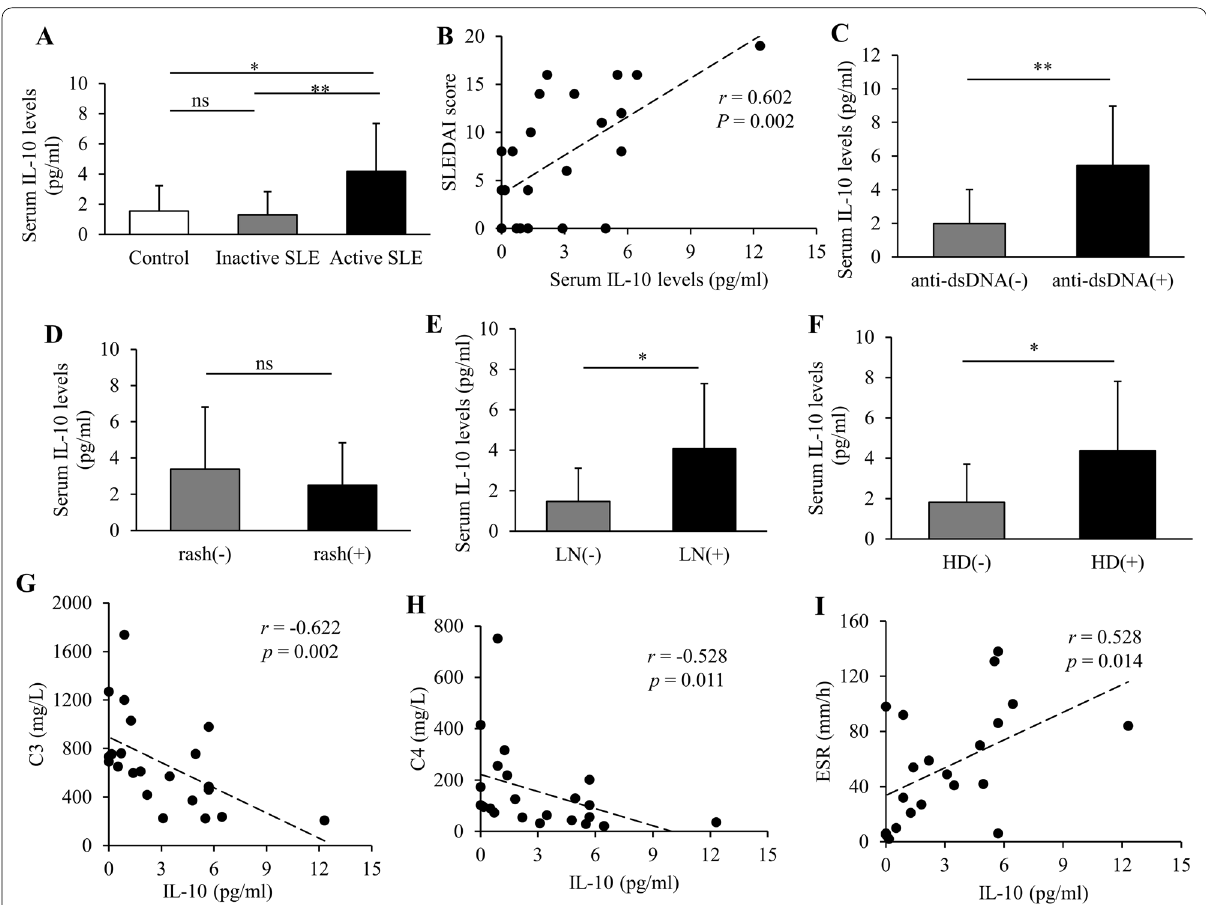
Fig. 4 Association of serum IL-10 levels with SLE-related parameters. A Serum IL-10 levels from healthy controls (n (SLEDAI score 4, n 10) and active SLE patients (SLEDAI score > 4, n 14). B Correlation of serum IL-10 levels with the SLEDAI score. C Serum IL-10 ≤ = = levels from anti-dsDNA positive patients (n 7) and anti-dsDNA negative patients (n 17). D – F Serum IL-10 levels in SLE patients with rash (n = = and without rash (n 13); with nephritis (n 14) and without nephritis (n 10); with hematological disorders (n = = = disorders (n 13). G – I Correlation of serum IL-10 levels with level of complement C3, C4 and ESR. * P < 0.05, ** P < 0.01, *** P < 0.001; ns, not significant =